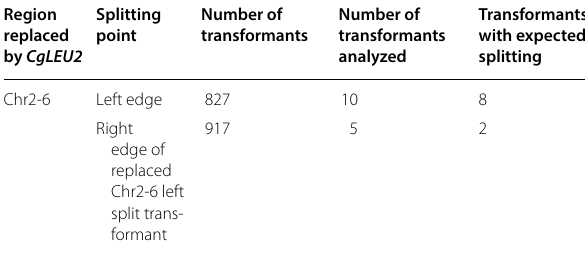
Table 3 Splitting left and right edge of replaced